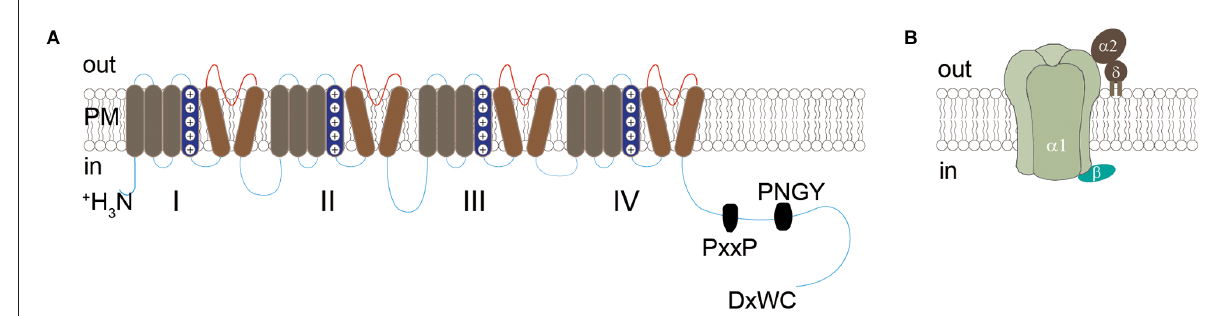
FIGURE1 Diagrammatic structure of CaV channels. (A) Structure of the α 1 subunit, which contains four homologous domains (I-IV) each with six transmembrane segments (S1-S6) and a long intracellular C-terminal. The cytoplasmic tail contains the conserved PxxP motif, PNGY motif, and C-terminal motif DxWC, which are known to be crucial for the synaptic assembly of CaV2 channels (see details in text). (B) Model of CaV channels showing the central pore-forming α 1 subunit, interacting with intracellular β subunit and extracellular α 2 δ subunit through a GPI anchor into the plasma